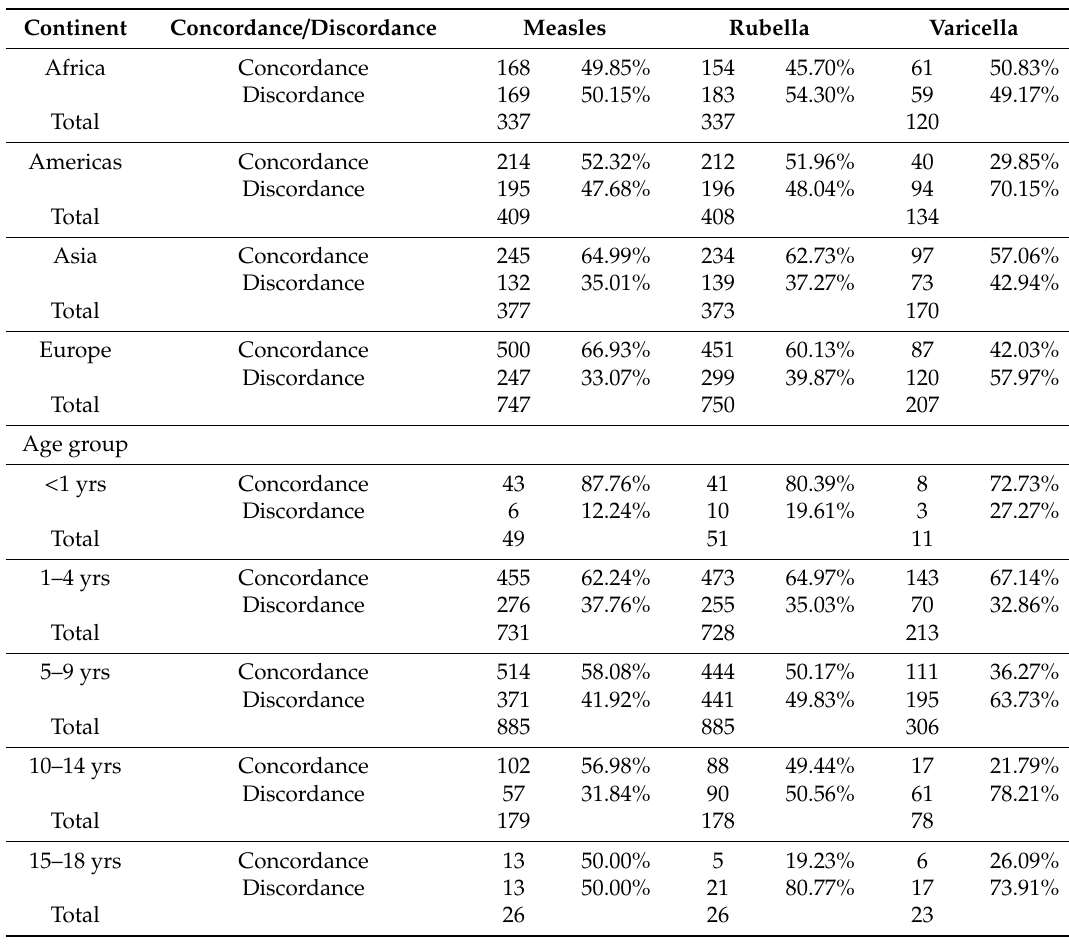
Table 5. Number and percentage of IAC with concordance and discordance between documentation records and serological results by continent of origin and age